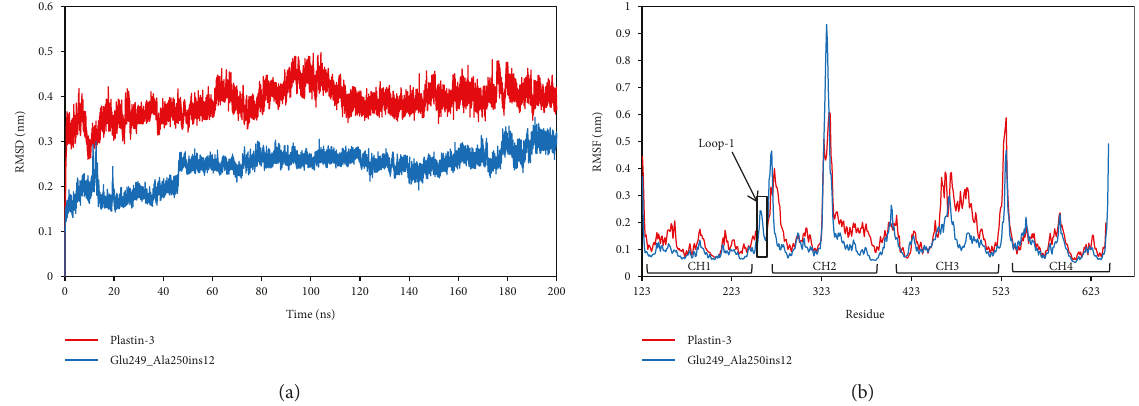
Figure 4: The RMSD is calculated on C α atoms of the wild-type plastin-3 (red) and the mutant (Glu249_Ala250ins12) (blue) structure (a), respectively. (b) Atomic fl uctuations (RMSF) is calculated from the C α of the wild-type (red) and mutant (blue) plastin-3 during MD